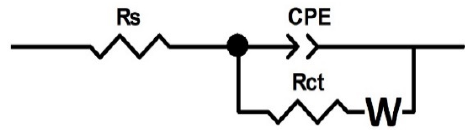
Figure 8. Equivalent circuit for spectra fitting.